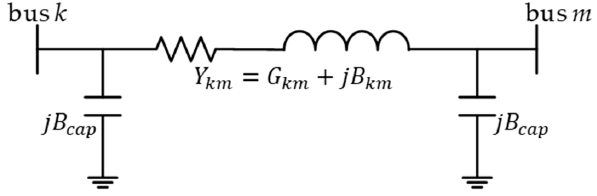
Figure 2. Transmission line π -equivalent model.